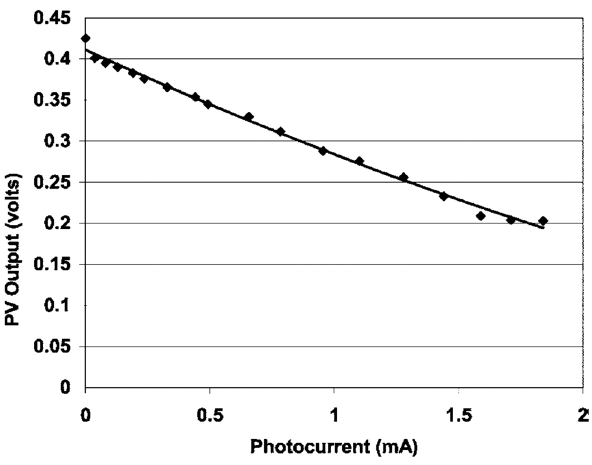
Figure 10: Photocurrent characteristics of an electrodeposited p - type Si layer onto n - type Si wafers [ 179 ] . Permission from Electrochemical